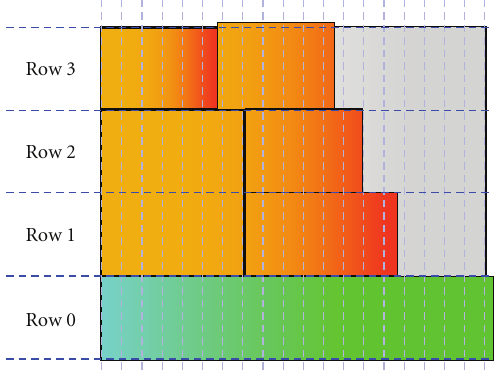
Figure 3: Limits of the floorplacement of big modules.